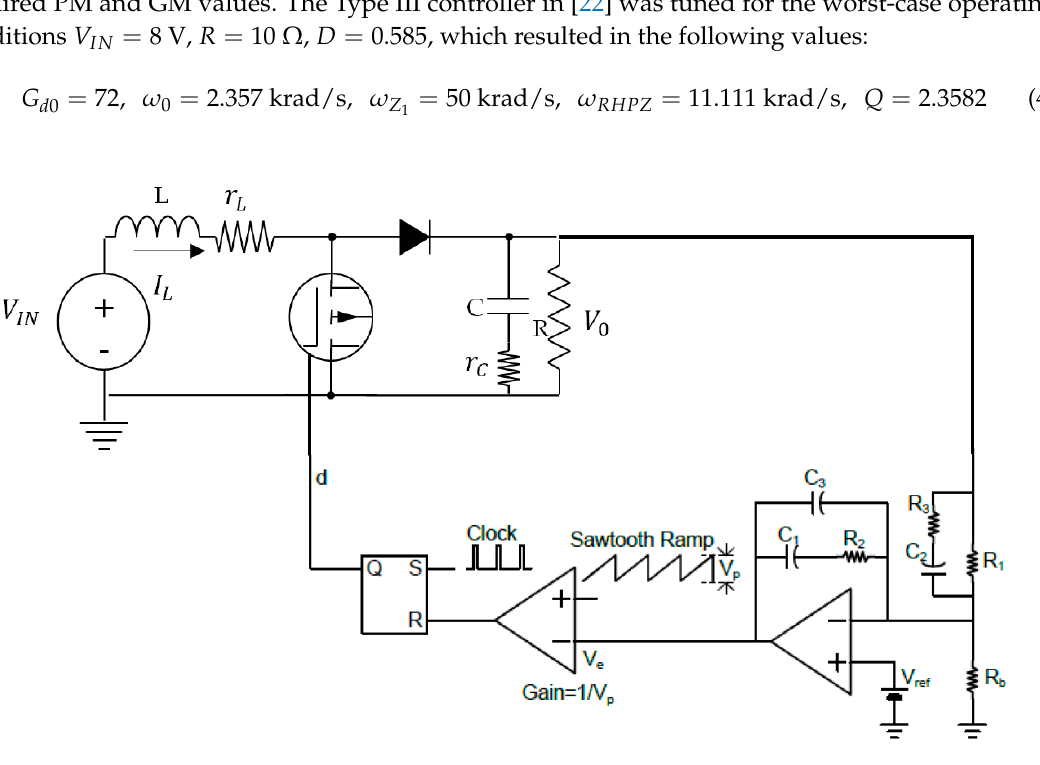
Figure 2. Type III voltage-mode compensation circuit.